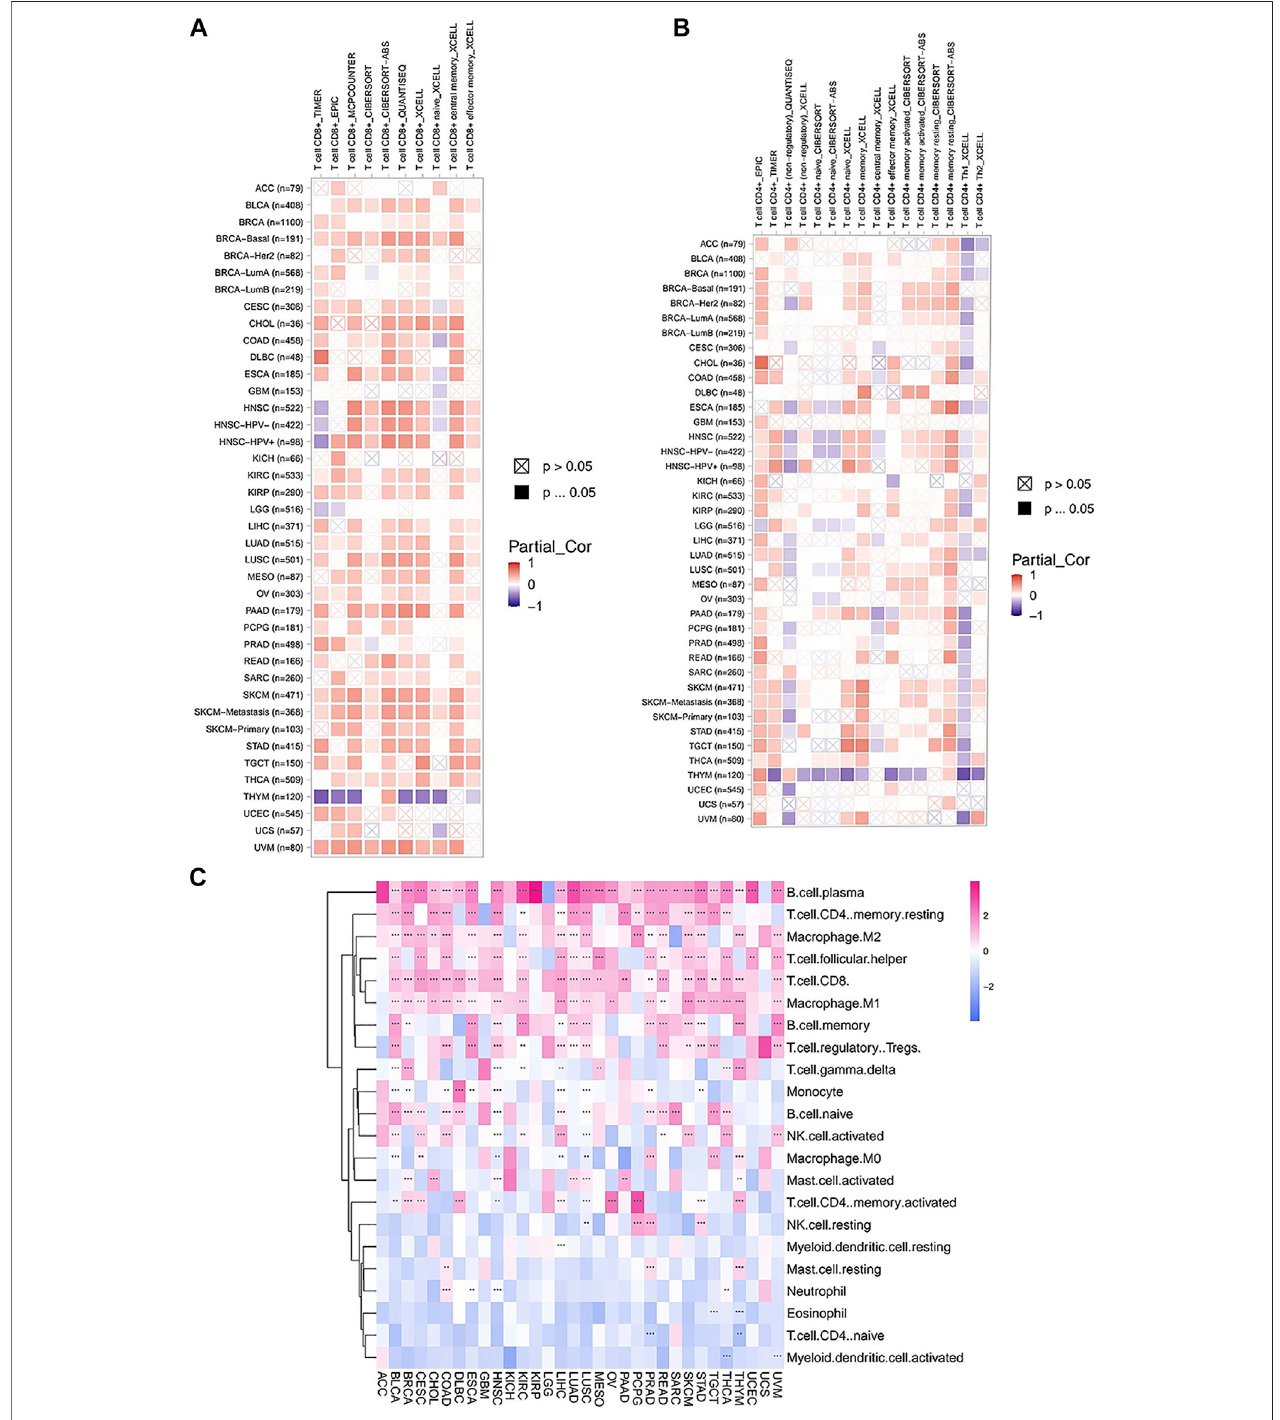
FIGURE 10 | Correlation analysis between FAM46C expression and immune in fi ltration of cells. Correlation of FAM46C expression with (A) CD8 + T-cell in fi ltration, (B) CD4 + T-cell in fi ltration and (C) different types of immune in fi ltrating cells in pan-cancer.